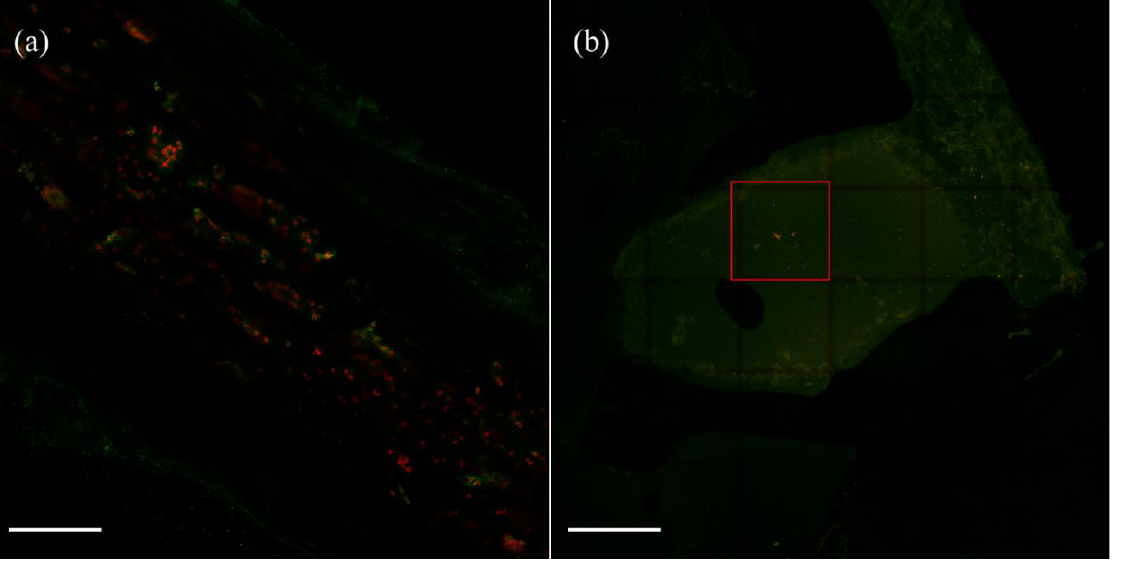
Figure 3. Bacterial colonization. Images of colonized M. sativa roots ( a ) and nodules ( b ) after 28 days of growth and inoculation with V. paradoxus S110 T marked with mCherry. Scale bars represent 600 μm in ( a ) and 1000 μm in ( b ). Red square in ( b ) marks a group of V. paradoxus S110 T marked with mCherry in the nitrogen fixation zone.